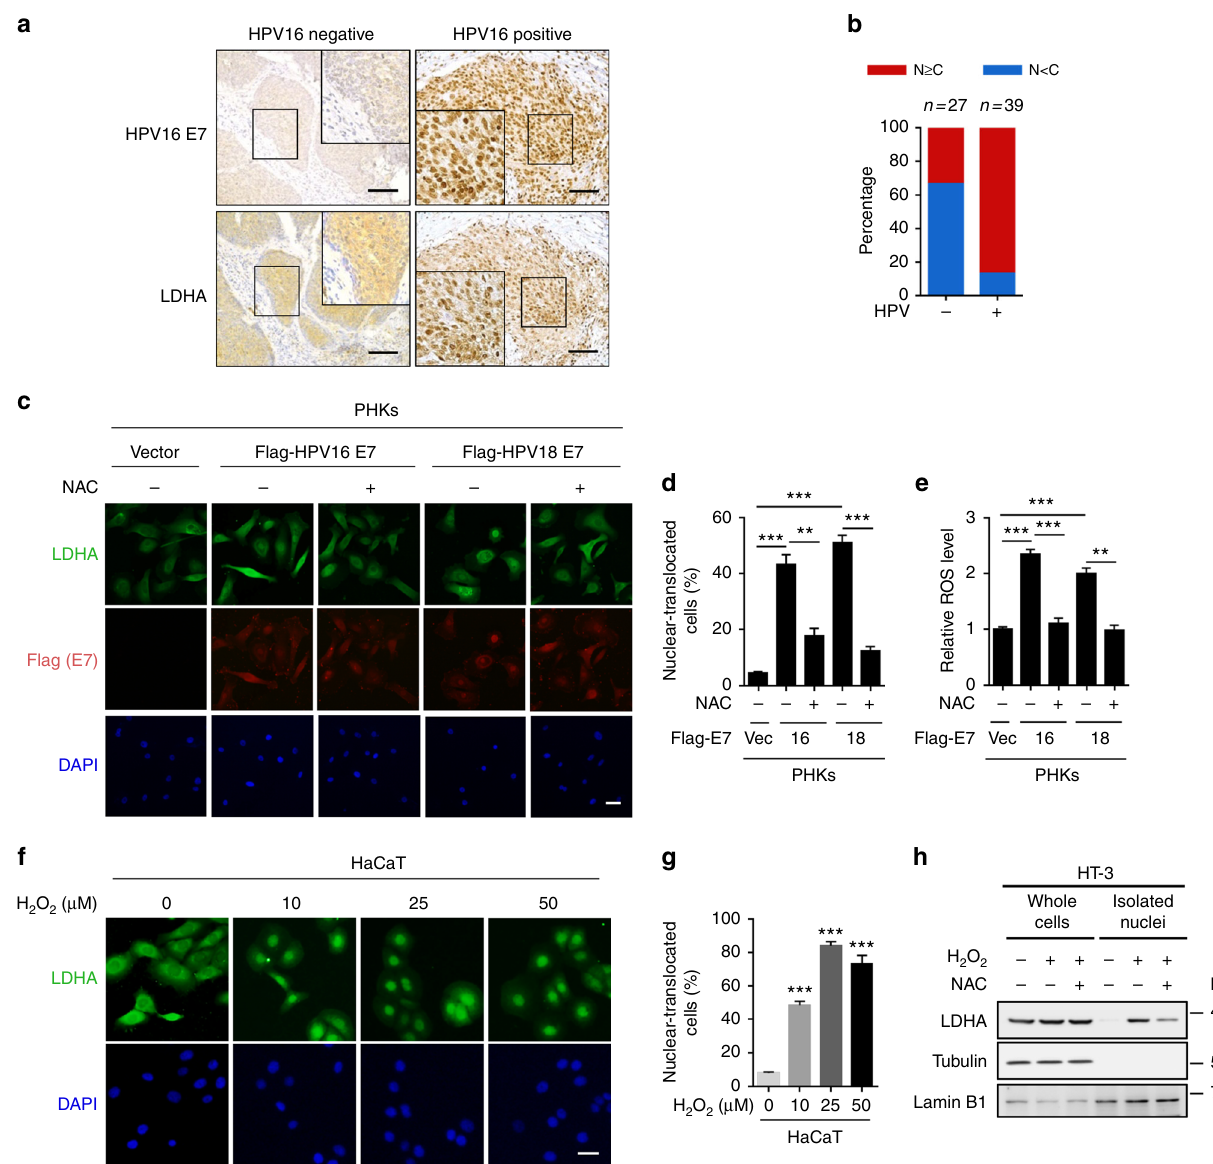
Fig. 1 HPV16/18 E7 induces LDHA nuclear translocation by ROS accumulation. a LDHA is signi fi cantly translocated into nucleus in HPV16 positive cervical cancer tissues. Representative IHC images for LDHA localization in HPV16-negative and positive cervical tumor samples. Scale bar, 100 μ m. b Nuclear LDHA is dramatically increased in HPV16-positive cervical cancer tissues. Semi-quantitative cytoplasmic LDHA and nuclear LDHA scoring was performed in HPV16 negative ( n = 27) and positive ( n = 39) cervical tumor samples. c , d HPV16/18 E7 promotes LDHA nuclear translocation in a ROS-dependent manner. Primary human cervix keratinocytes (PHKs) stably expressing vector or Flag-tagged HPV16/18 E7 were treated with or without 1 mM NAC for 6 h, followed by staining with anti-LDHA (green), anti-Flag (red) antibodies, and DAPI (blue). Scale bars, 10 μ m ( c ). The percentage of cells with nucleus- localized LDHA compared to total cell number was quanti fi ed ( d ). e HPV16/18 E7 enhances ROS production. Cellular ROS were measured in PHKs stably expressing vector or HPV16/18 E7 coupled with or without 1 mM NAC treatment for 6 h, followed by using the ROS-sensitive fl uorescent dye (CM- H 2 DCFDA) with fl ow cytometry according to the manufacturer ’ s protocol. f , g LDHA nuclear translocation is profoundly increased in an H 2 O 2 -dose- dependent manner. Immuno fl uorescent images of LDHA (green) in HaCaT cells upon different dose of H 2 O 2 treatment as indicated. DAPI, blue. Scale bars, 10 μ m ( f ). The percentage of cells with nucleus-localized LDHA compared with total cell number was quanti fi ed ( g ). h ROS promote LDHA nuclear translocation. HT-3 cells were treated with or without 10 μ M H 2 O 2 for 6 h, and supplemented with or without 1 mM NAC for extended 6 h as indicated for nuclear isolating, followed by blotting with LDHA, Tubulin, and Lamin B1. Results are representative of three independent experiments. All data are shown as mean ± SEM. The p values were determined by two-tailed t -test. The values of p < 0.05 were considered statistically signi fi cant. *, **, and *** denote p < 0.05, p < 0.01, and p < 0.001, respectively. NS means non signi fi